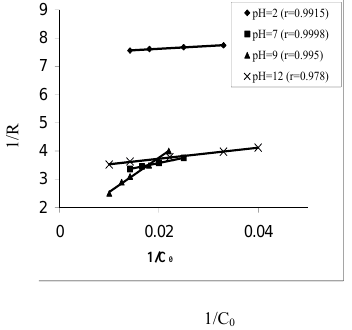
Figure 6. The plots of 1/R vs . 1/C for degradation of tolonium chloride in the presence of anatase TiO